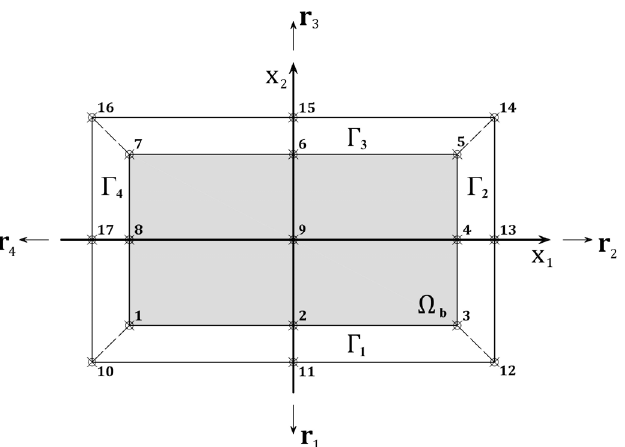
Figure 5: Unit cell meshless